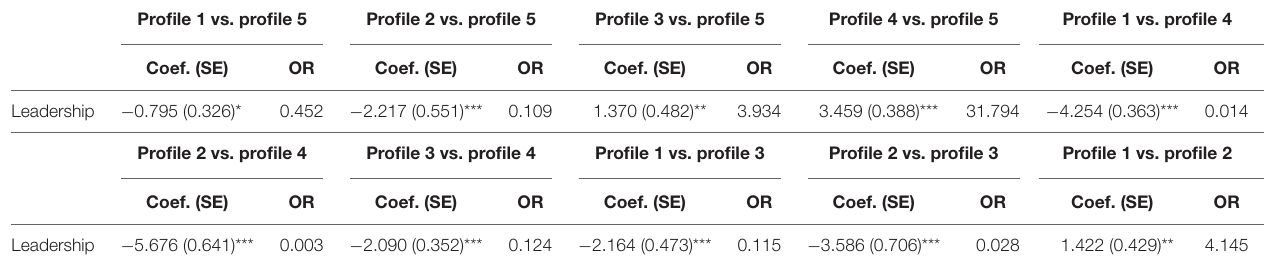
TABLE 4 | Results from multinomial logistic regressions for the effects of transformational leadership on profile membership (bifactor